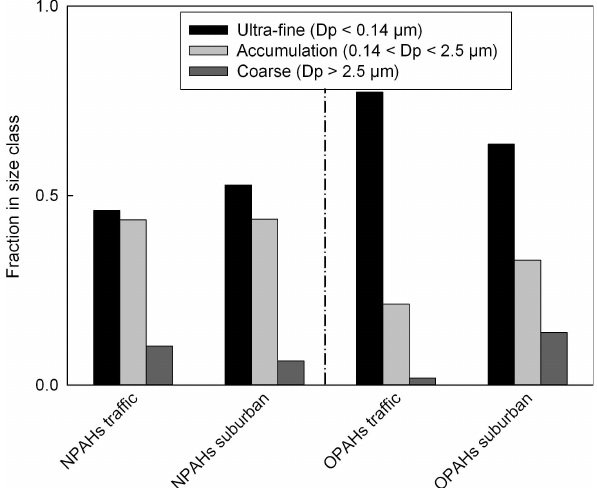
Fig. 1. Average NPAH and OPAH concentration fractions in the different particle size classes at the traffic and suburban sites. The percentage of NPAHs and OPAHs in each size class is based on the total OPAH and NPAH